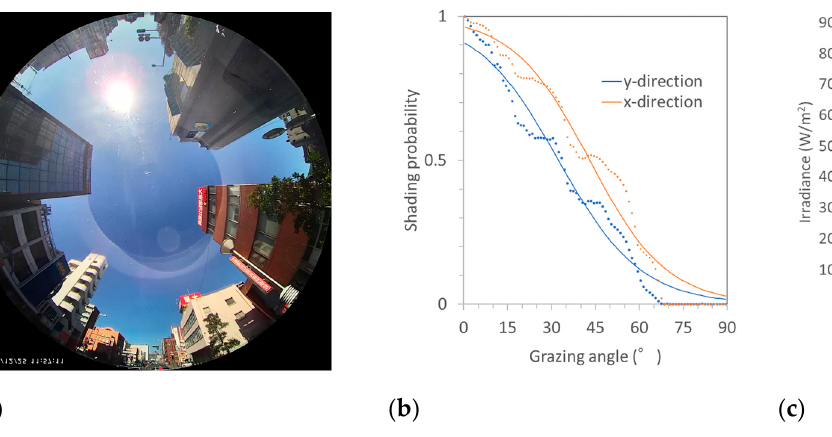
Figure 10. Shading distribution and irradiance onto VIPVs (5-axis) of the building zone: ( a ) fisheye image; ( b ) shading probability as the function of the grazing angle; ( c ) comparison of the measured (red bars) and calculated (blue bars) irradiance onto 5-axis planes.